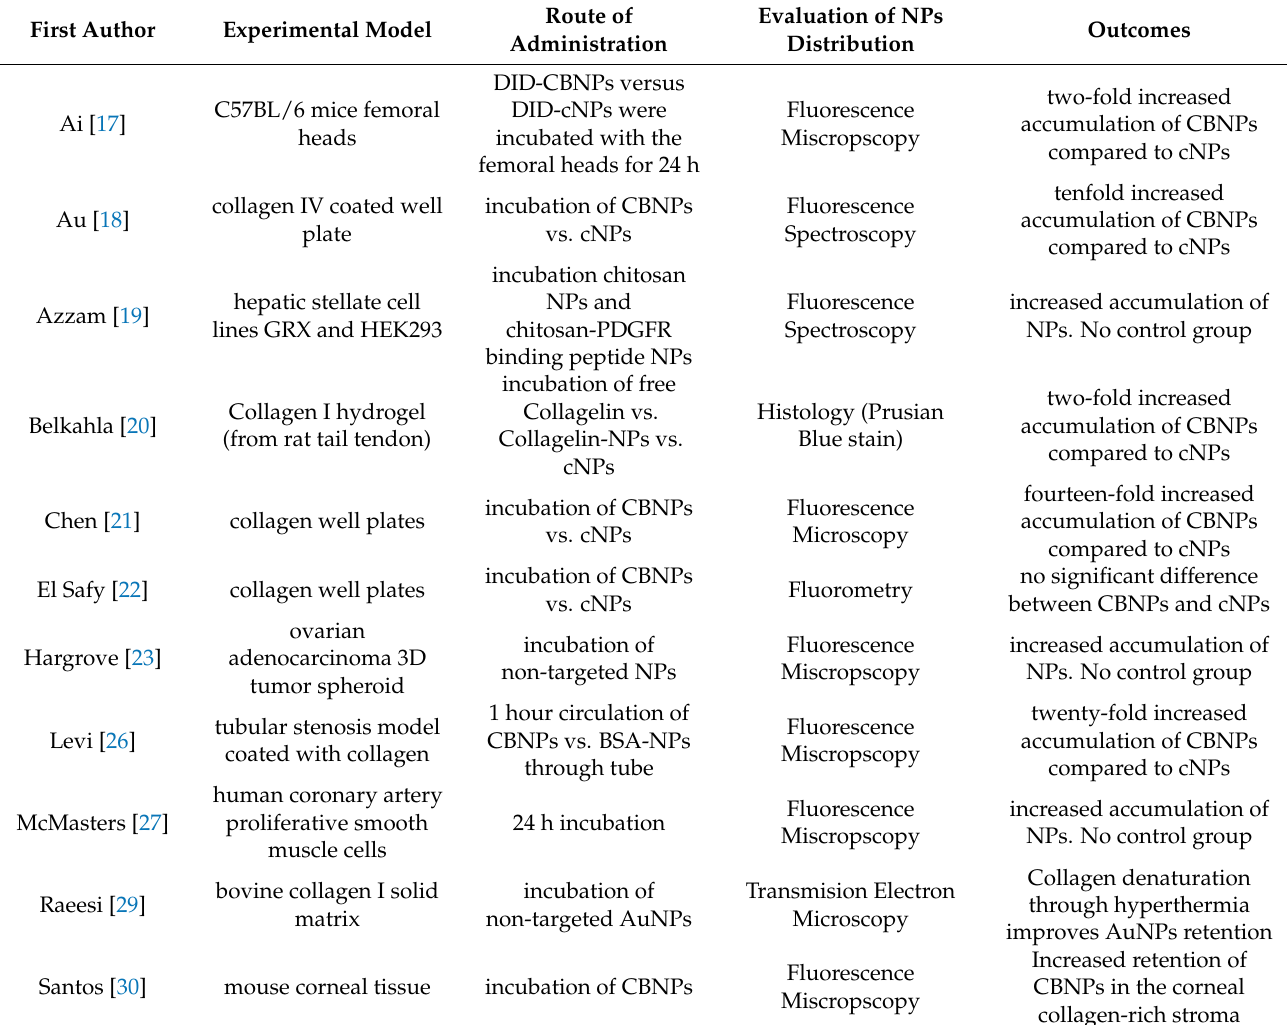
Table 3. In vitro